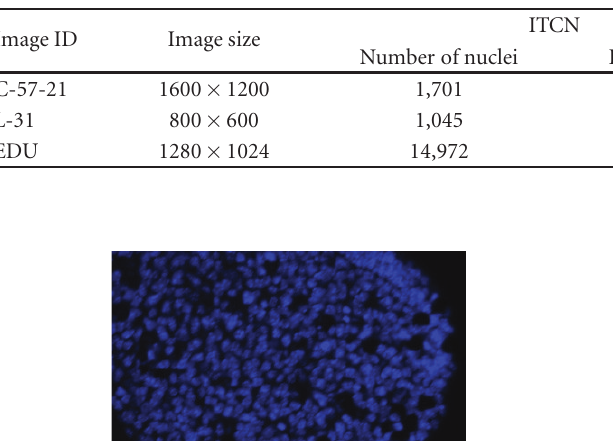
Table 1: Comparison between ITCN and ICS counts and processing times.